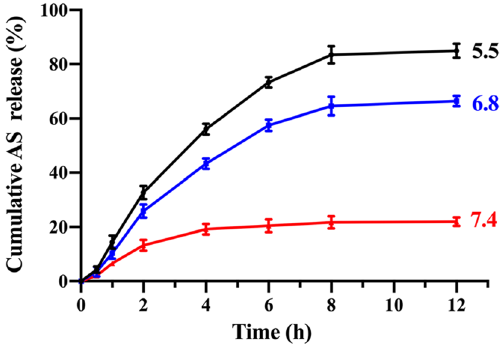
Figure 3. Cumulative AS release percentage against time in PBS with three different pH (5.5, 6.8, and 7.4). Data are presented as mean ± SD, n = 3.